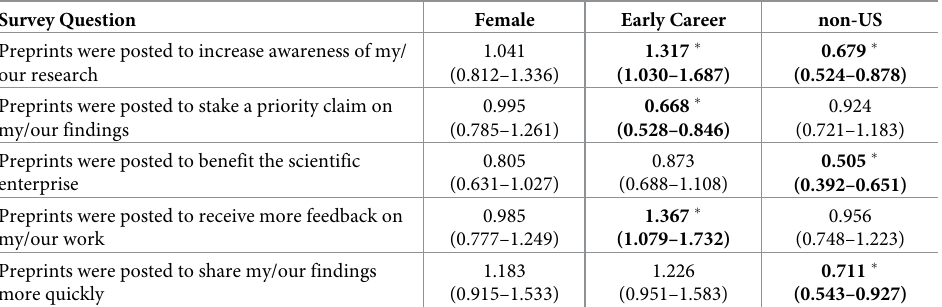
Table 2. Results of ordinal logistic regression for survey questions in Fig 5 (corresponding authorships only; N = 1146). Values are presented as exponentiated odds-ratios, with the range in parentheses representing 95% confi- dence intervals. Significant results at the 95% level are indicated in bold and with “ �